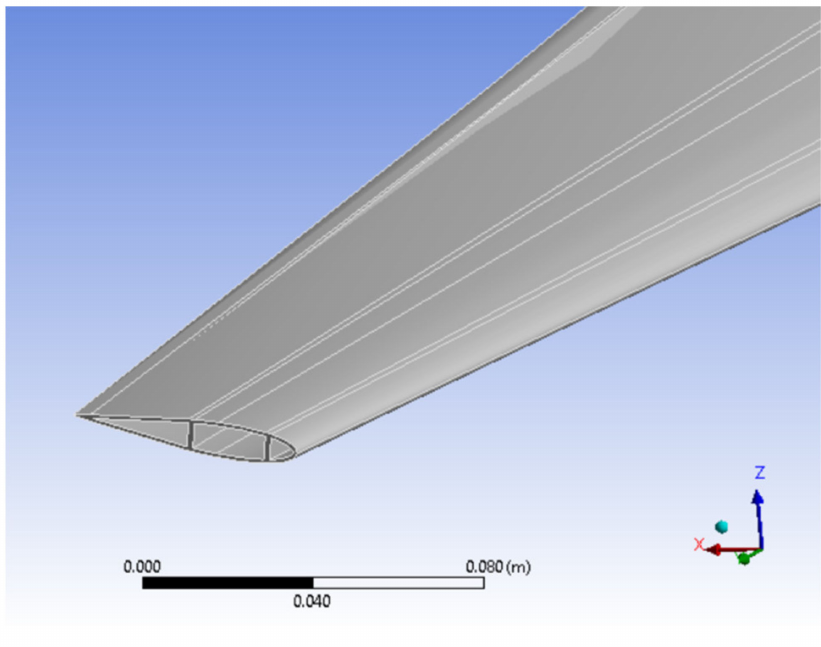
Figure 2. 3D model of geometry of optimized HAWT